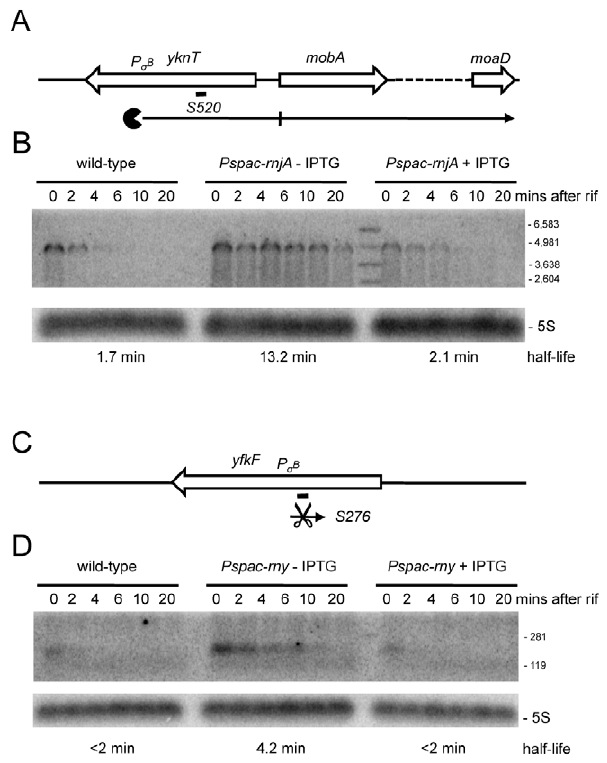
Figure 9. Detection of new potential asRNAs in RNase Y and J1 mutants. (A) Structure and predicted degradation pathways of the S520 RNA antisense to yknT . ORFs are shown as large white arrows, transcripts as thin black arrows. Scissors indicate cleavage by RNase Y, ‘Pacman’ symbols represent 5 9 -3 9 degradation by RNase J1. A short thick line indicates the position of the probe used. P s B indicates the putative promoter and sigma factor for the regulatory RNA predicted by the DBTBS website (http://dbtbs.hgc.jp/) and in agreement with the size detected by Northern blot. (B) Northern blot of total mRNA isolated at times after addition of rifampicin (rif) from wild-type and RNase J1 depleted ( Pspac-rnjA 2 IPTG) and RNase J1 induced ( Pspac-rnjA + IPTG) cells. The blot was probed with 5 9 -labeled oligo CCB857 (Table S6) and reprobed with oligo HP246 against 5S rRNA. The half-life of the S520 transcript is given under the Northern blot. Migration positions of RNA markers are shown to the right of the blot. (C) Structure and predicted degradation pathway of the S276 RNA antisense to yfkF . Features as in panel (A). (D) Northern blot of total mRNA isolated at times after addition of rifampicin (rif) from wild-type and RNase Y depleted ( Pspac- rny 2 IPTG) and RNase Y induced ( Pspac-rny + IPTG) cells. The blot was probed with 5 9 -labeled oligo CCB859 (Table S6) and reprobed with oligo HP246 against 5S rRNA. Description as in panel (B).